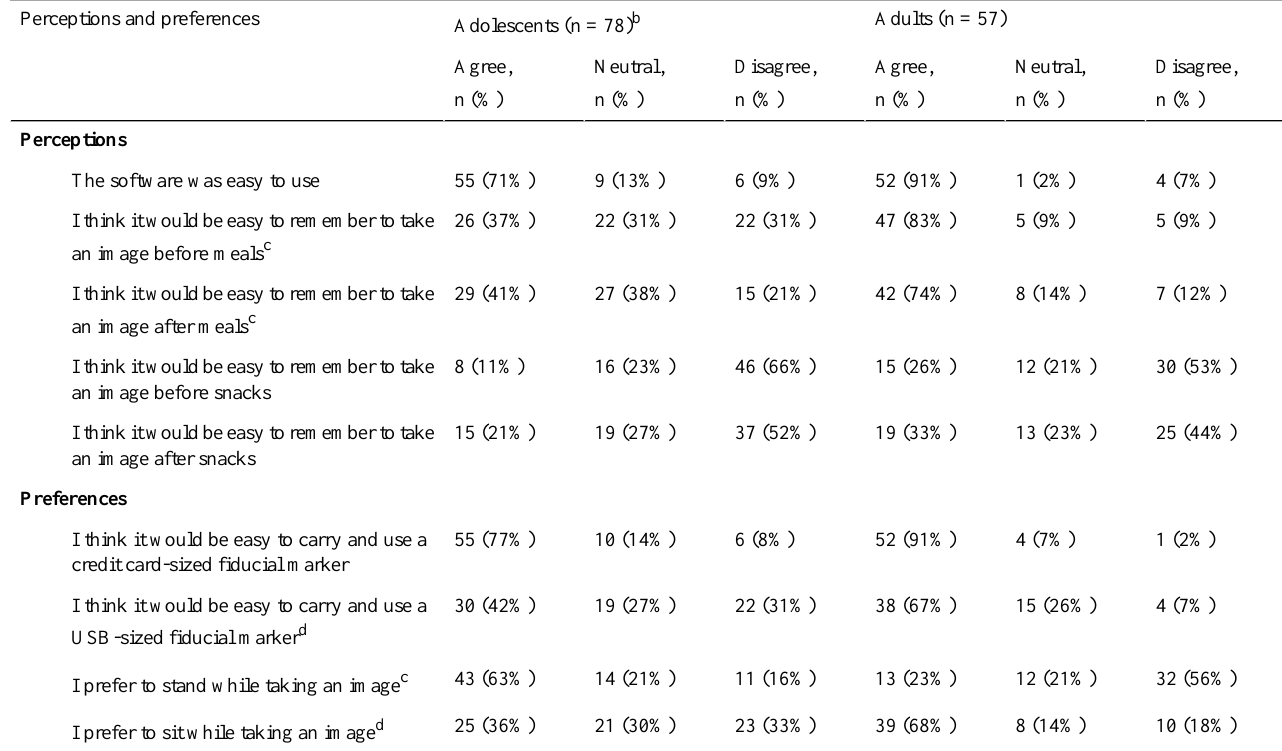
Table 4. Comparison of perceptions and preferences between adolescents and adults regarding use of the mobile telephone food record a .